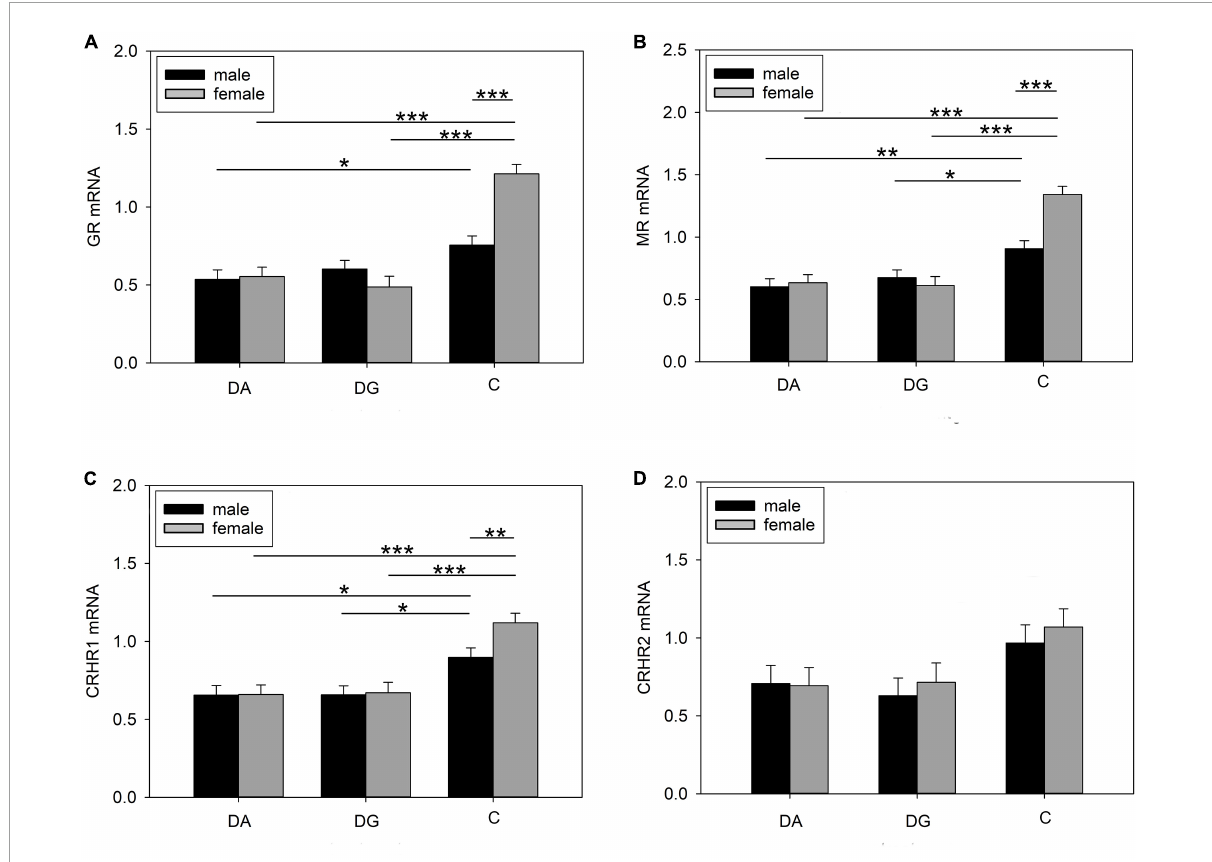
FIGURE8 Gene expression in the PFC of piglets on PND 20. (A) GR (glucocorticoid receptor; NR3C1), (B) MR (mineralocorticoid receptor; NR3C2), (C) CRHR1 (corticotropin releasing hormone receptor 1) and (D) CRHR2 mRNA expression and MR/GR ratio of DA (deprivation alone), DG (deprivation with a group of littermates), and C (control, no deprivation) piglets. Data are expressed as arbitrary units after normalization to ACTB and TBP mRNA expression as endogenous reference genes and represent the LS means ± SE. Significant differences are indicated by asterisks (* p < 0.05; ** p < 0.01; *** p < 0.001; Tukey-Kramer test; n = 10 per treatment group and